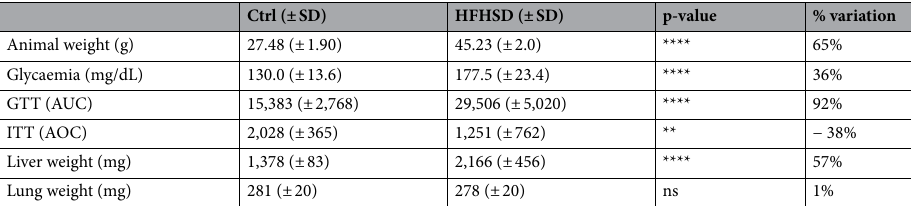
Table 1. Physiological parameters of SD and HFHSD mice. Results are expressed as mean ± standard deviation (SD). Data are mean of n = 12 mice per group for total weight, glycaemia, GTT and ITT (glucose and insulin resistance test respectively) and n = 8 mice per group for liver and lung weight; Results of unpaired two-tailed t-test are indicated as non-significant (ns), p < 0.01 (**) and p < 0.0001 (****). Percentages of variation between HFHSD and control fed mice are